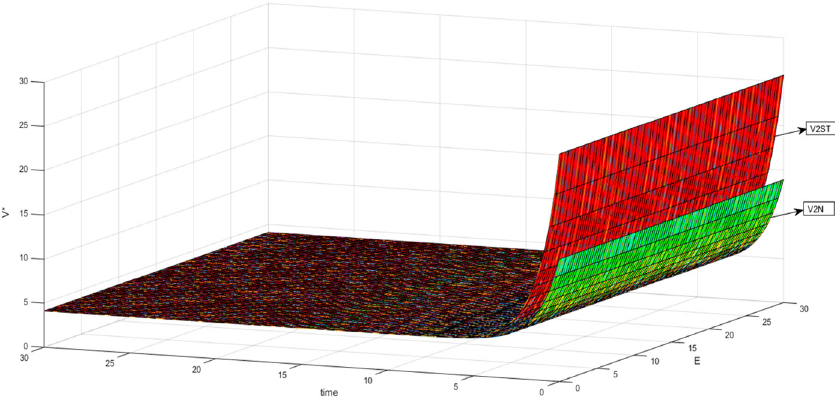
Figure 2: The change of enterprise ’ s optimal bene fi t under noncooperative game and Stackelberg